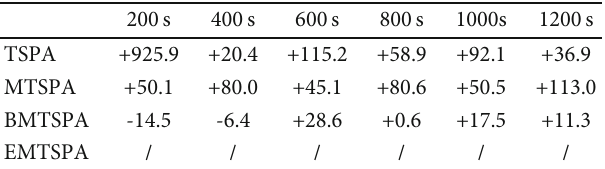
Figure 12: GMDR in di ff erent test time. Table 3: Comparison of